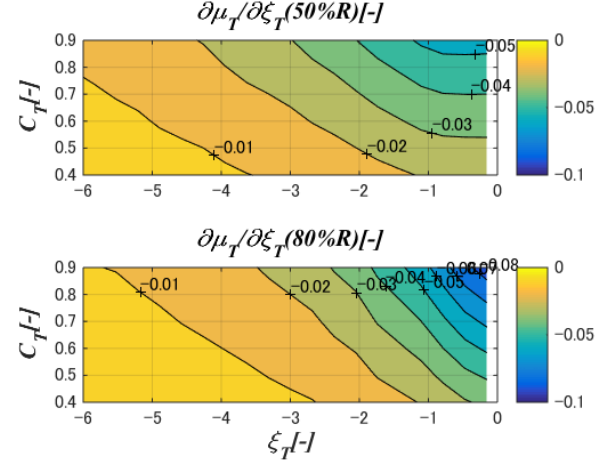
Figure 12. Spatial differential of wind speed in front of the rotor ( ∂μ T / ∂ξ T ) as obtained by CFD.